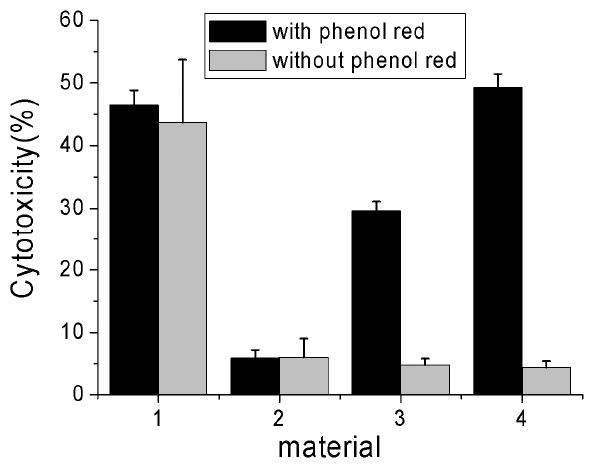
Figure 5. Cytotoxicity assessment of Hela cells exposed to MWNTs, PG, S160 and P90 (denoted by 1, 2, 3 and 4, respectively) in serum-free medium with or without phenol red. All data shown are the mean values of three experiments ±